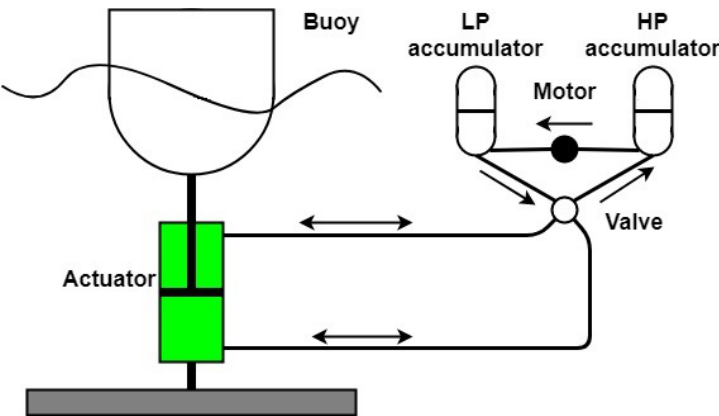
Figure 1. General layout for a hydraulic power take-off